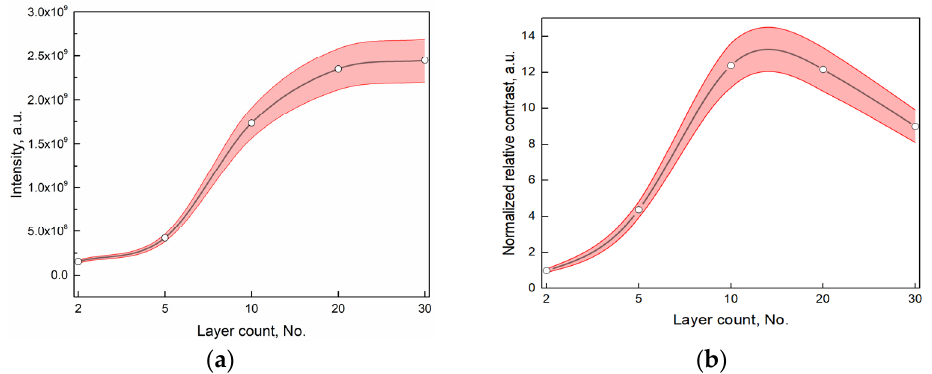
Figure 5. ( a ) The integral luminescence intensity of 3D-printed samples with di ff erent counts of ML layers; ( b ) the normalized contrast for 8 mm de fl ection; points are connected with a spline function for illustrative purposes; the red region represents the estimated 10% error.